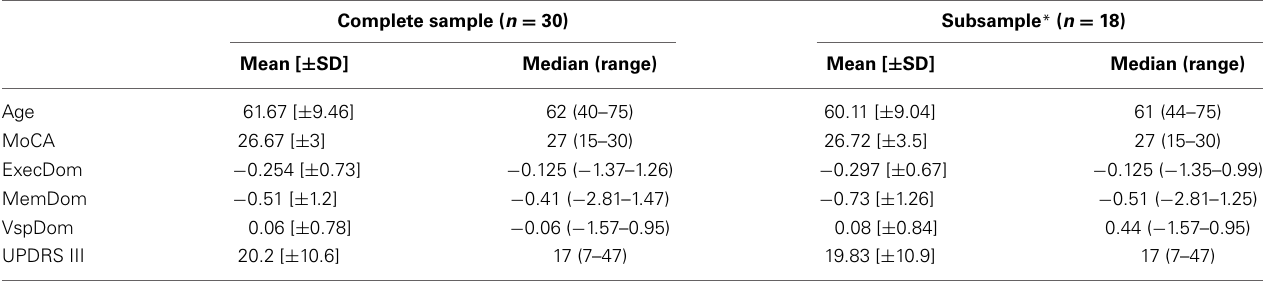
Table 1 | Demographics and clinical data.